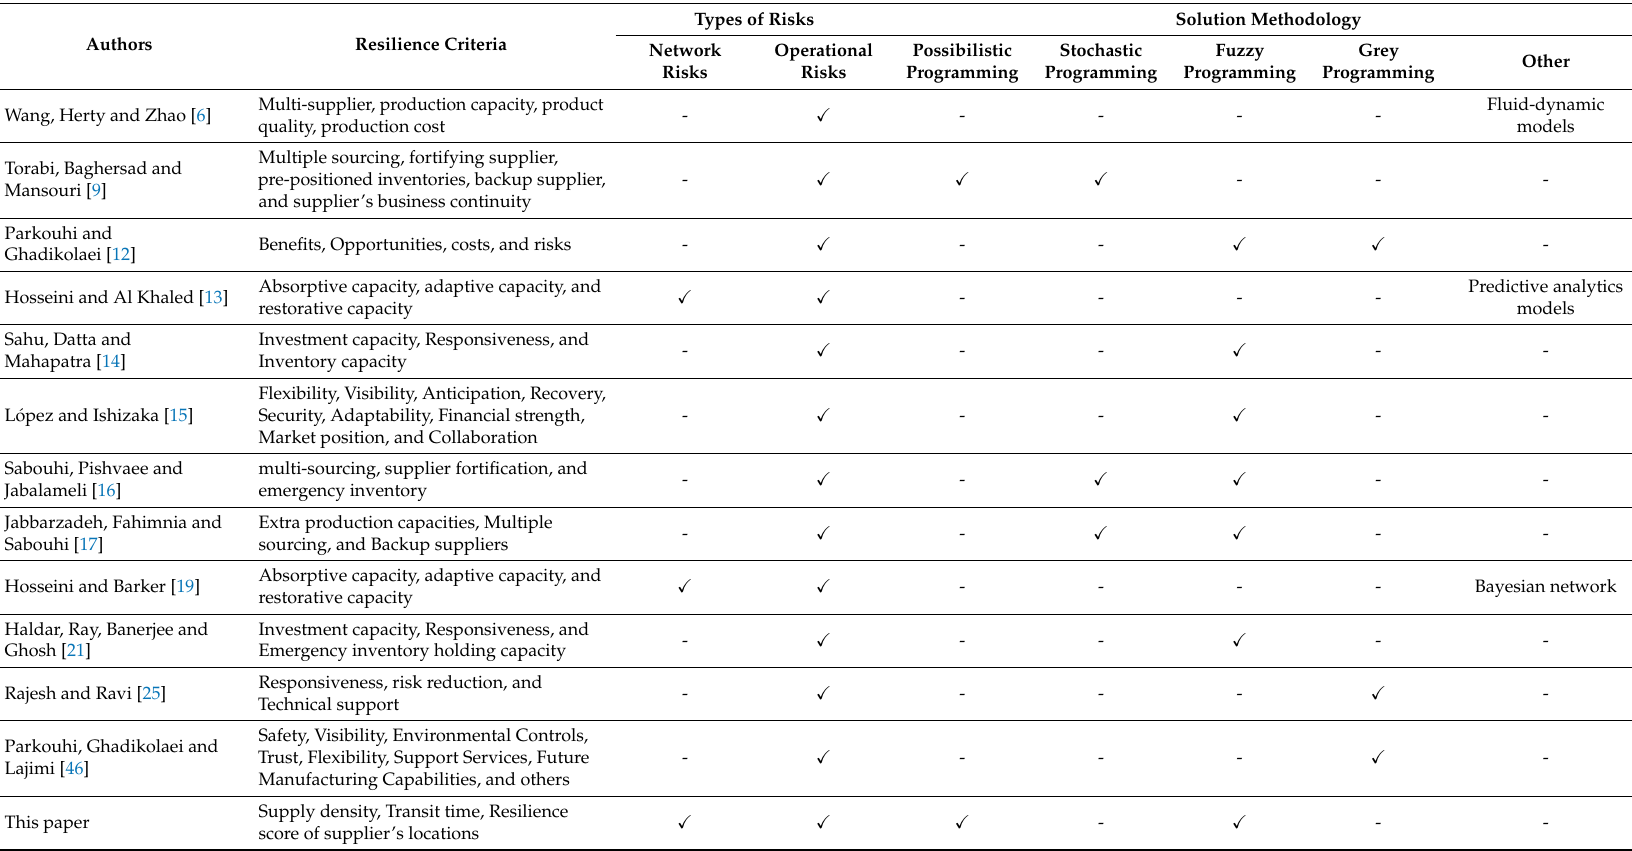
Table 1. The classification of literature in resilient supplier